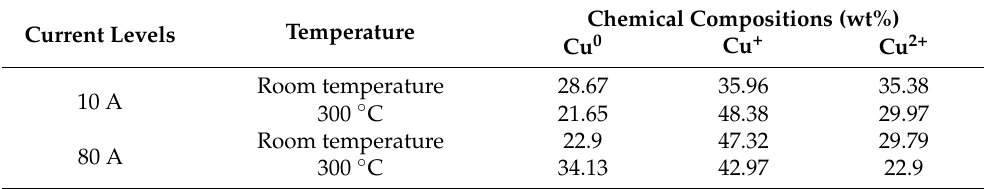
Table 4. XPS quantitative analysis of the percentage of copper with a different valence on the carbon surface under different interface